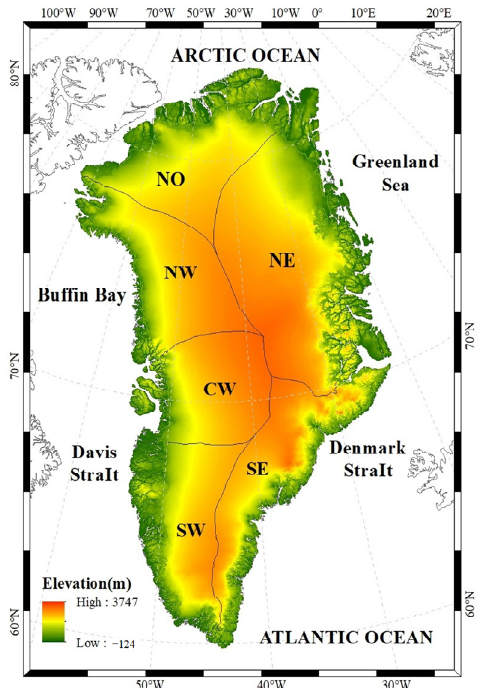
Figure 1. Greenland topography map. Elevation model created by Greenland Ice Sheet Mapping Project (GIMP, 90 m) [42].